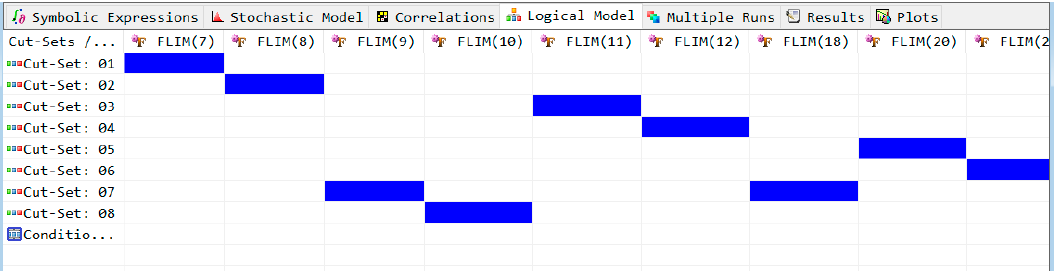
Figure 7. Results of the reliability analysis in the SYSREL program for the simplified model. The great advantage of the FORM method during the reliability analysis is the op- portunity to obtain the values of α coefficient for all random variables. This provides in- formation on how large the influence of any variable changes on the structure reliability is. If α has a positive sign, it means that increasing the corresponding random variable will result in increased reliability. If α is negative, the situation is opposite: an increase in the variable’s value causes the decrease of structure reliability. In Figure 8, values of α for all random variables are presented.